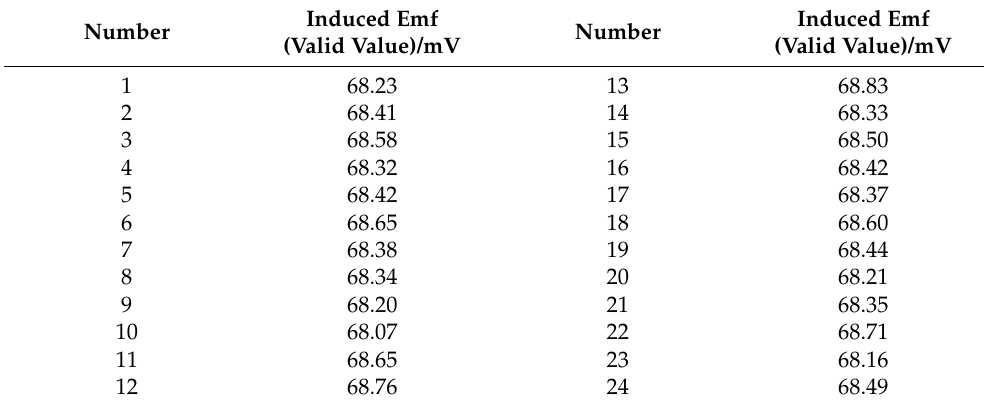
Table 2. Collected values of the induced electromotive force.